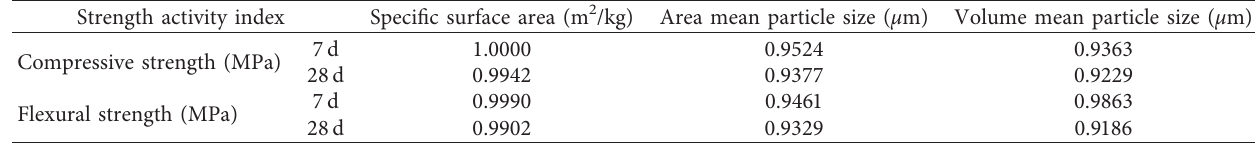
Table 5: Grey entropy of mortar strength activity index and BP particle characteristic.